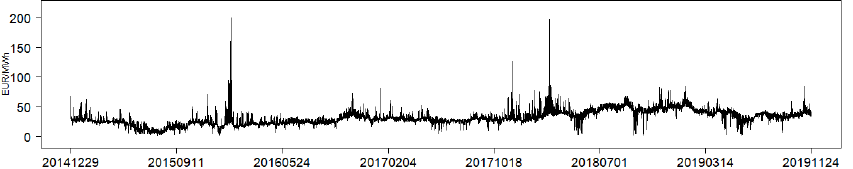
Figure 1. The system price in the Nord Pool day-ahead market in the period between 29 December 2014 and 24 November